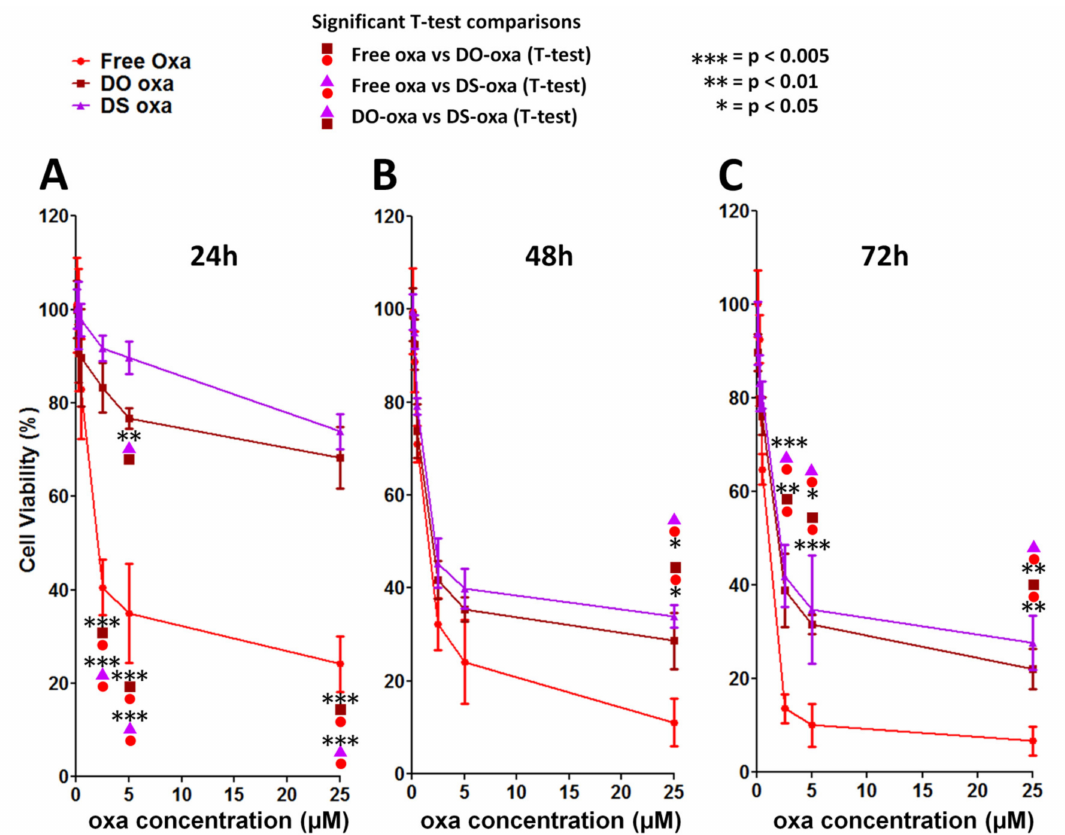
Figure 5. Viability of cells treated with free oxaliplatin and oxaliplatin-loaded liposomes. HCT-116 cell viability was measured by MTT assay at ( A ) 24 h, ( B ) 48 h and ( C ) 72 h. Experiments were performed in three independent replicates. Error bars represent standard deviations. Statistical significance was calculated by one-way two-tailed